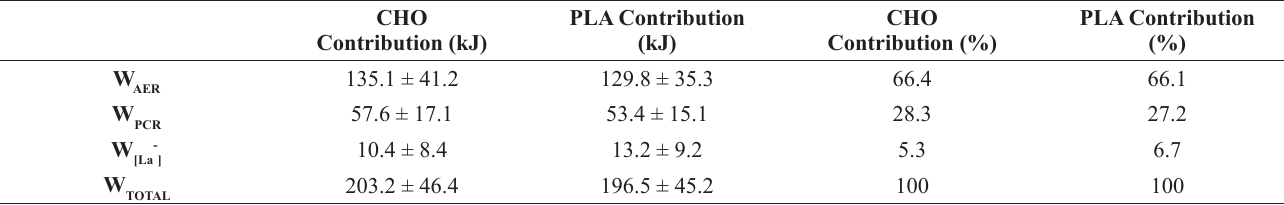
Table 1. Energy systems contribution in CHO and PLA